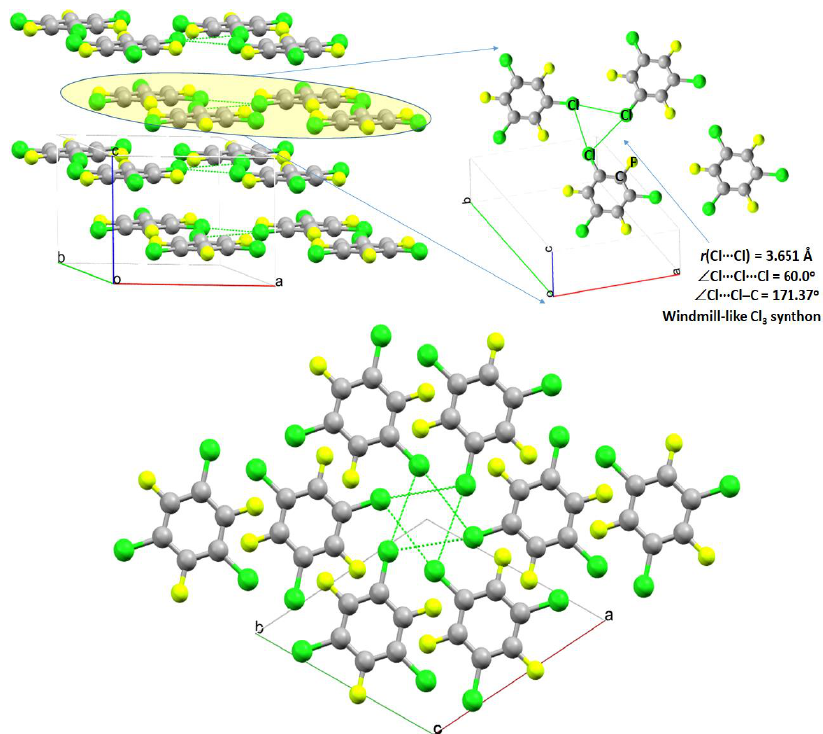
Figure 7. The windmill-like X 3 topology found in the structure of the crystal of 1,3,5-Trichloro-2,4,6-trifluorobenzene (CSD ref: BARBO). The Cl atom in each molecule in the crystal engages with another two Cl atoms of two neighboring same molecules to form the synthon, responsible for the formation of 2D layer structure.